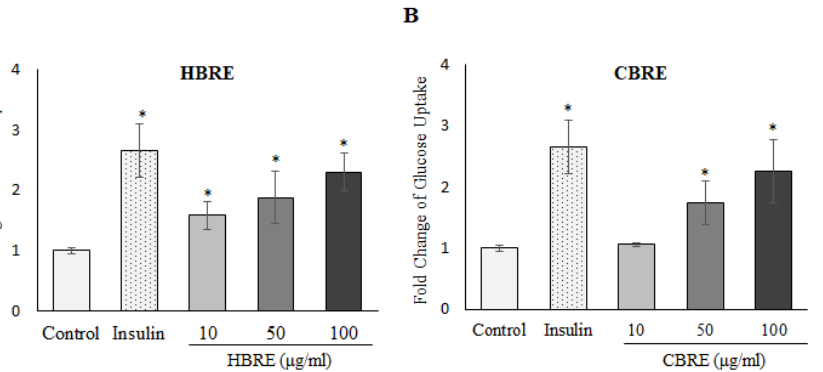
Figure 2. Effect of black rice extracts on glucose uptake by C2C12 myotubes. The 2-NBDG glucose uptake analysis was measured after a 24-h treatment with the indicated concentrations of ( A ) HBRE and ( B ) CBRE. Data are presented means ± SD, * p < 0.05 vs. control